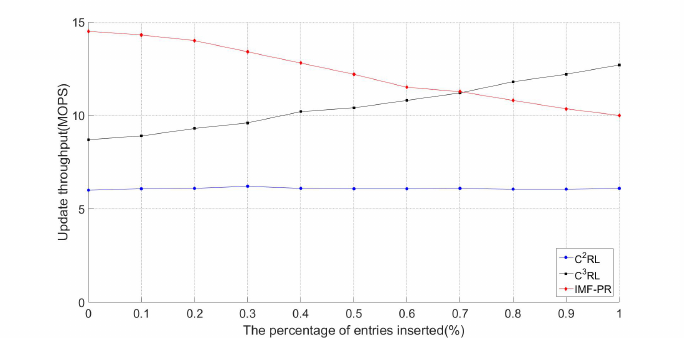
Figure 13. Update throughput. ( α =